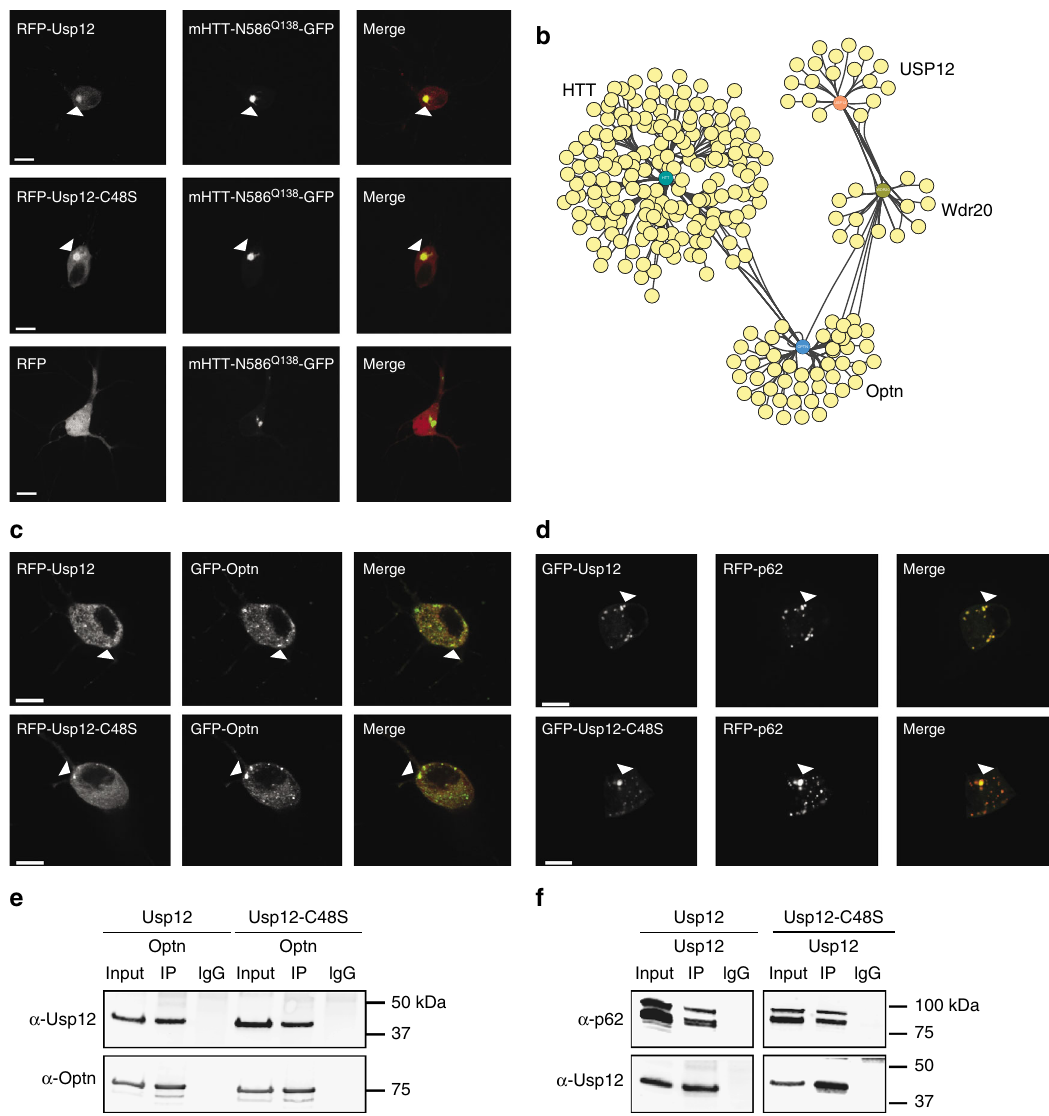
Fig. 5 Usp12 localizes to mHTT-N586 Q138 inclusion bodies and autophagy receptors. a Representative images of RFP-Usp12 and mHTT-N568 Q138 -GFP expression and localization in primary neurons. Images were captured in live cells approximately 48 h after transfection. Co-localization of Usp12 puncta and IBs is indicated (arrowheads). b Map of protein interaction networks between HTT, Usp12, Wdr20, and Optn, based on data collection in BioGRID. Detailed map is in Supplementary Fig. 7. c Representative images of GFP- or RFP-Usp12 and -Usp12-C48S neurons co-transfected with either GFP-Optn or d RFP-p62 and treated with NH 4 Cl. Co-localization of Usp12 and Optineurin or p62 puncta is indicated (arrowheads), scale bar = 10 µ m. e , f Immunoprecipitation of Optn ( e ) or Usp12 ( f ), followed by immunoblotting with anti-Usp12, anti-Optn, or anti-p62 antibodies in HEK cells transfected with Usp12, Usp12-C48S, Optn, or RFP-p62 as